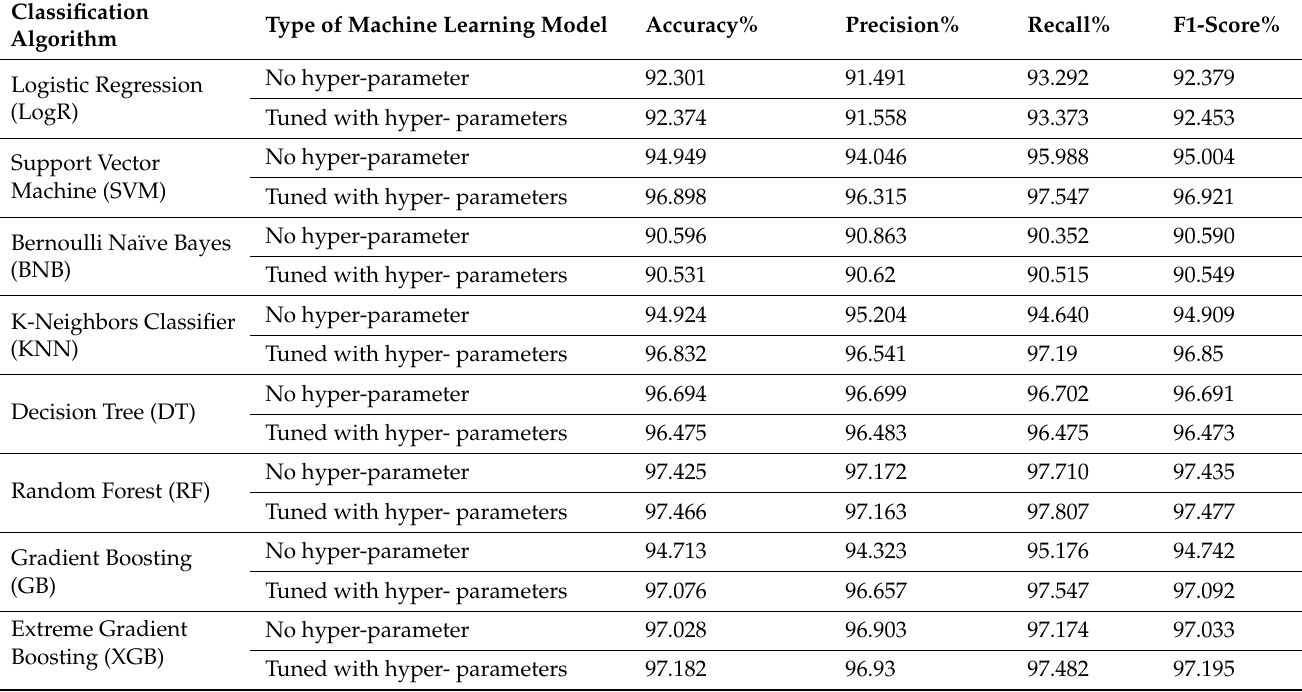
Table 11. Performance comparison of hyper-parameter tuned and untuned model for